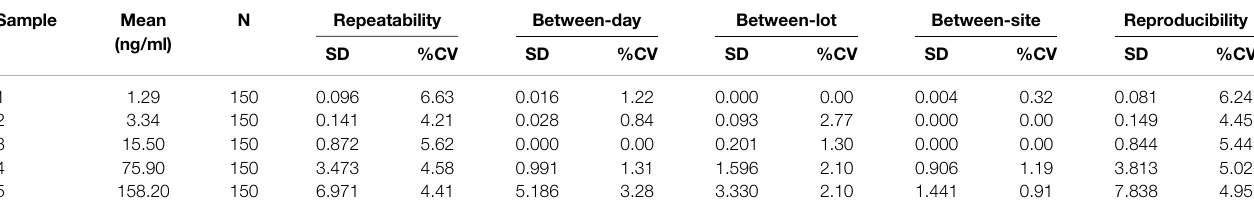
TABLE 3 | Statistical analysis for multi-site precision.